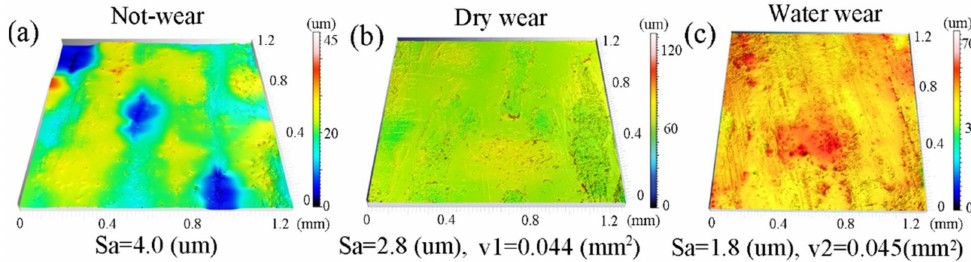
Figure 8. The 3D profile of the composite ( a ) before wear, ( b ) after dry sliding wear and ( c ) after water-lubricated wear.